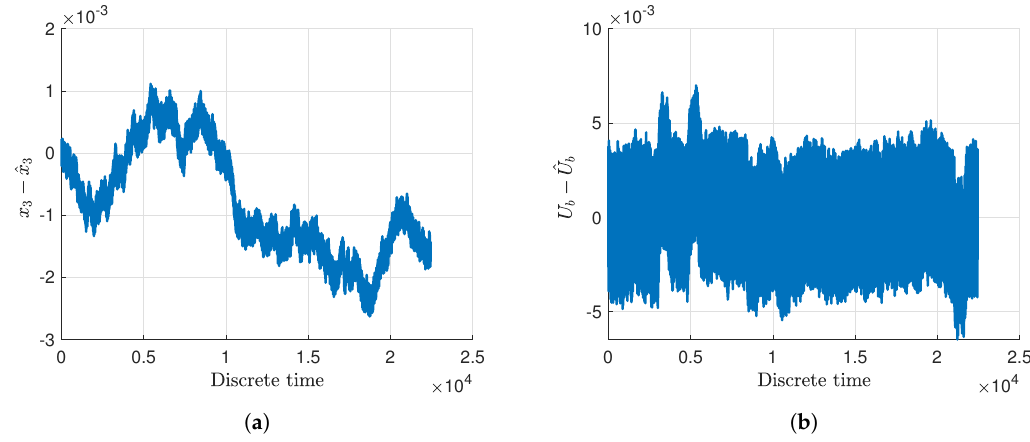
Figure 7. Evolution of the state estimation error for the SOC ( a ) and U b ( b